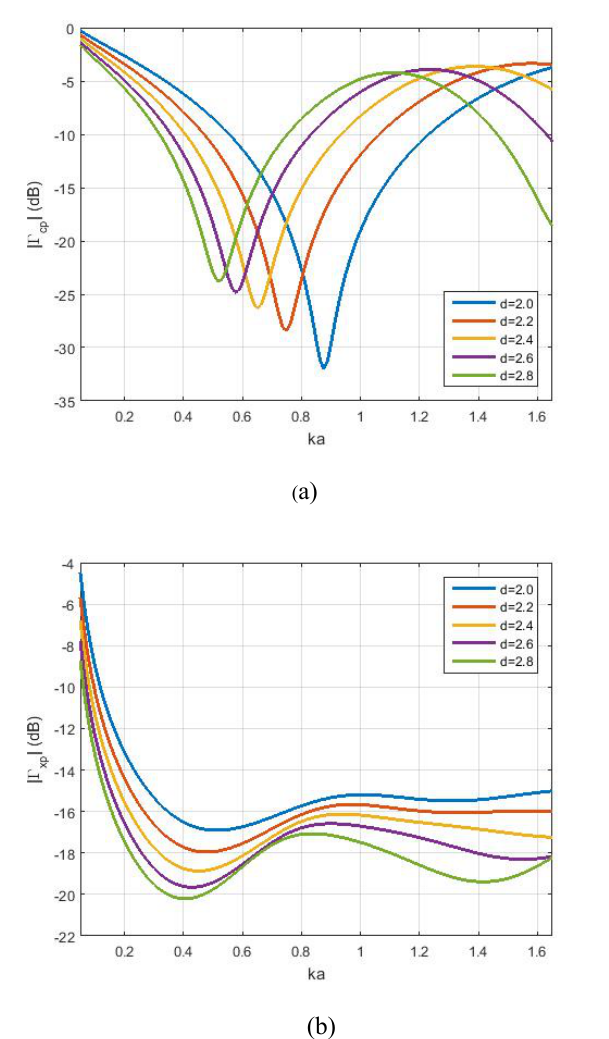
Figure 5: Variations of the total electric field magnitudes at P with ka for the buried cylinders of radius a in Fig. 4.